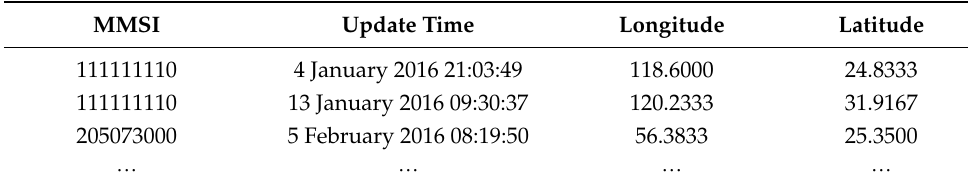
Table 1. Some attributes of AIS